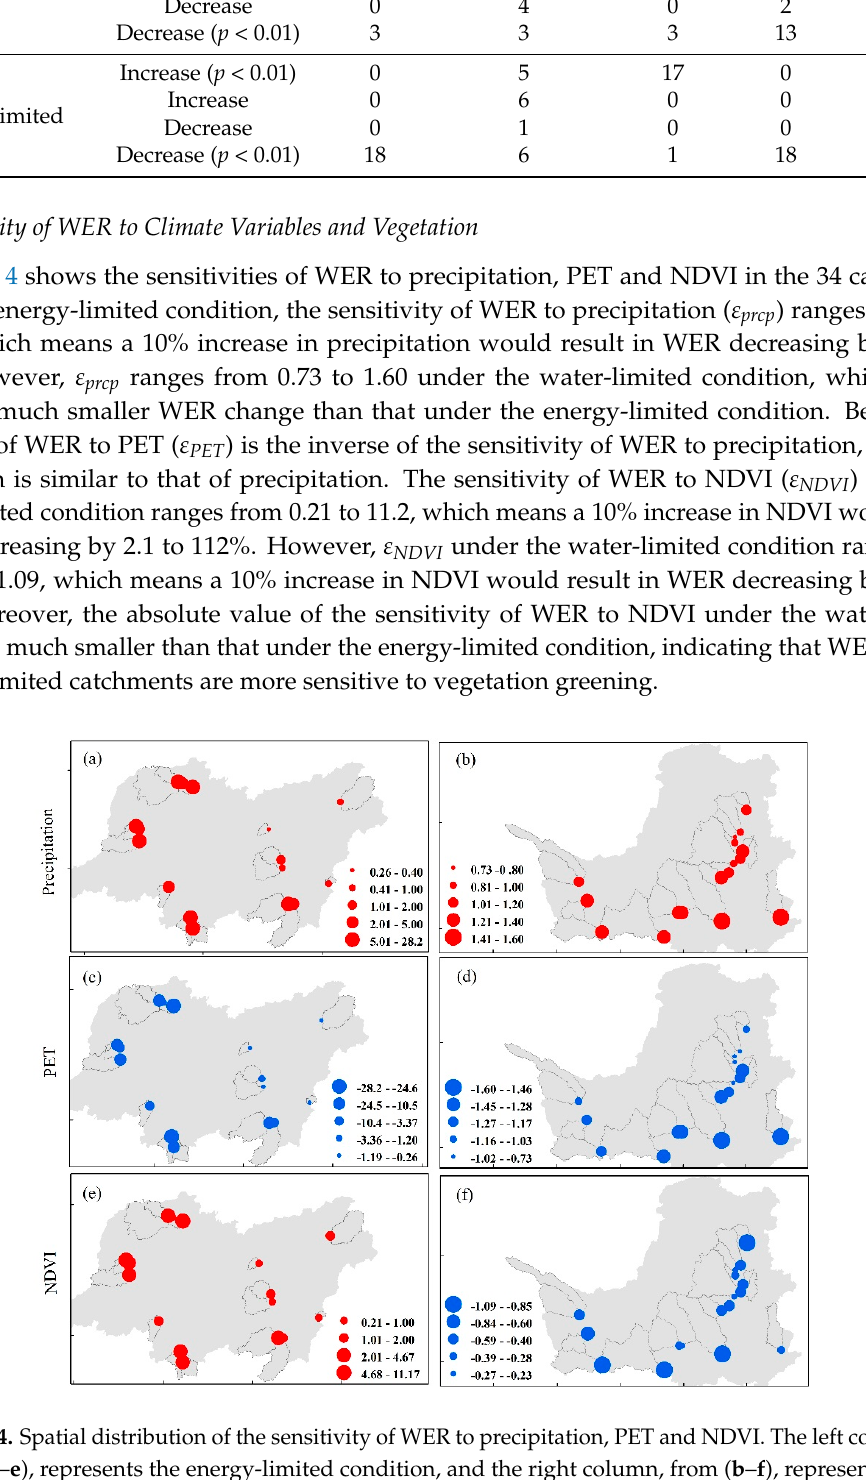
Table 4. Numbers of catchments in four categories of trends for WER, climate variables and NDVI.